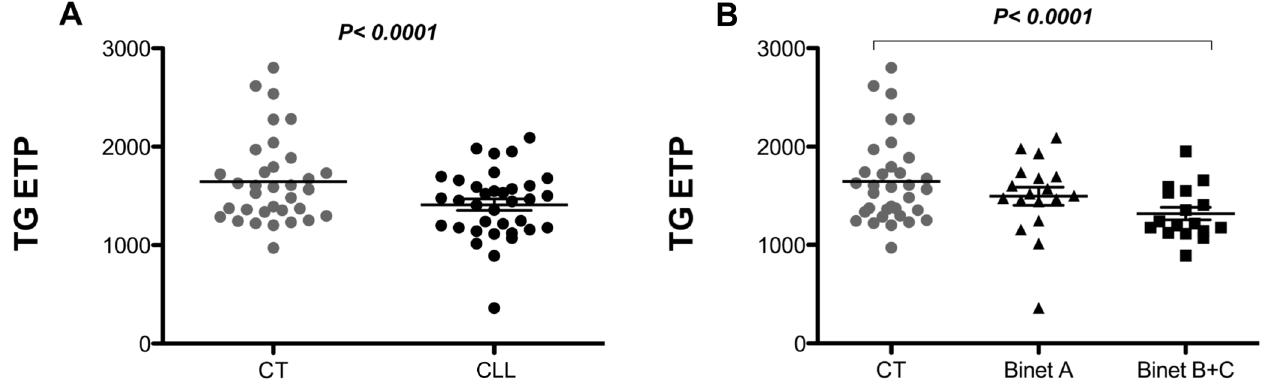
FIGURE 4 - ETP in plasma samples from patients with CLL and controls (A). In B, the patients were stratified according to the Binet stage (1981). The Y axis corresponds to the